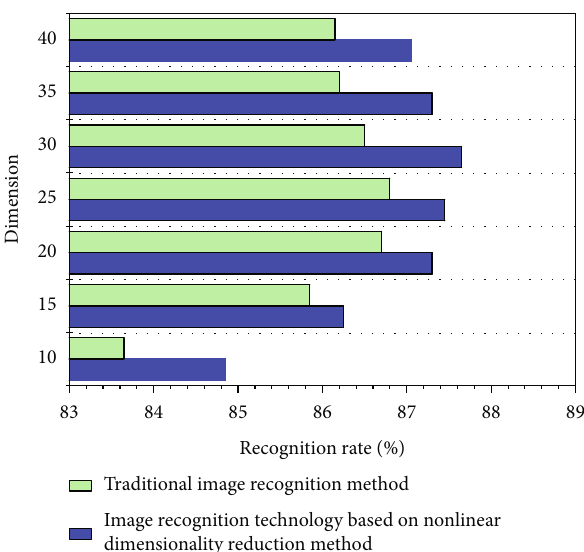
Figure 5: Comparison of recognition rates of di ff erent feature dimensions after optimization.